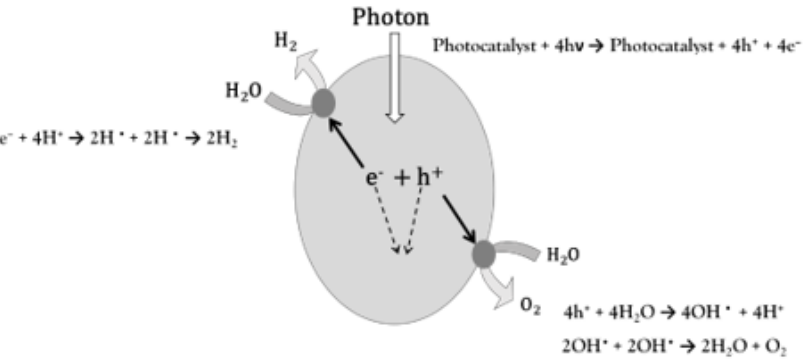
Figure 30. Schematic illustration of the process involved during water splitting with the photocatalyst under the illumination of sunlight.